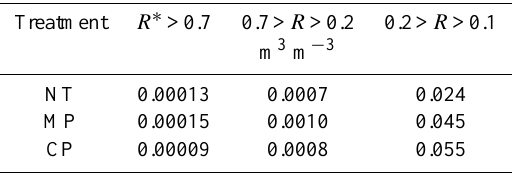
Table 4. Effective porosity calculated for each pore class and tillage treatment: moldboard plow (MP), chisel plow (CP), and no tillage (NT).